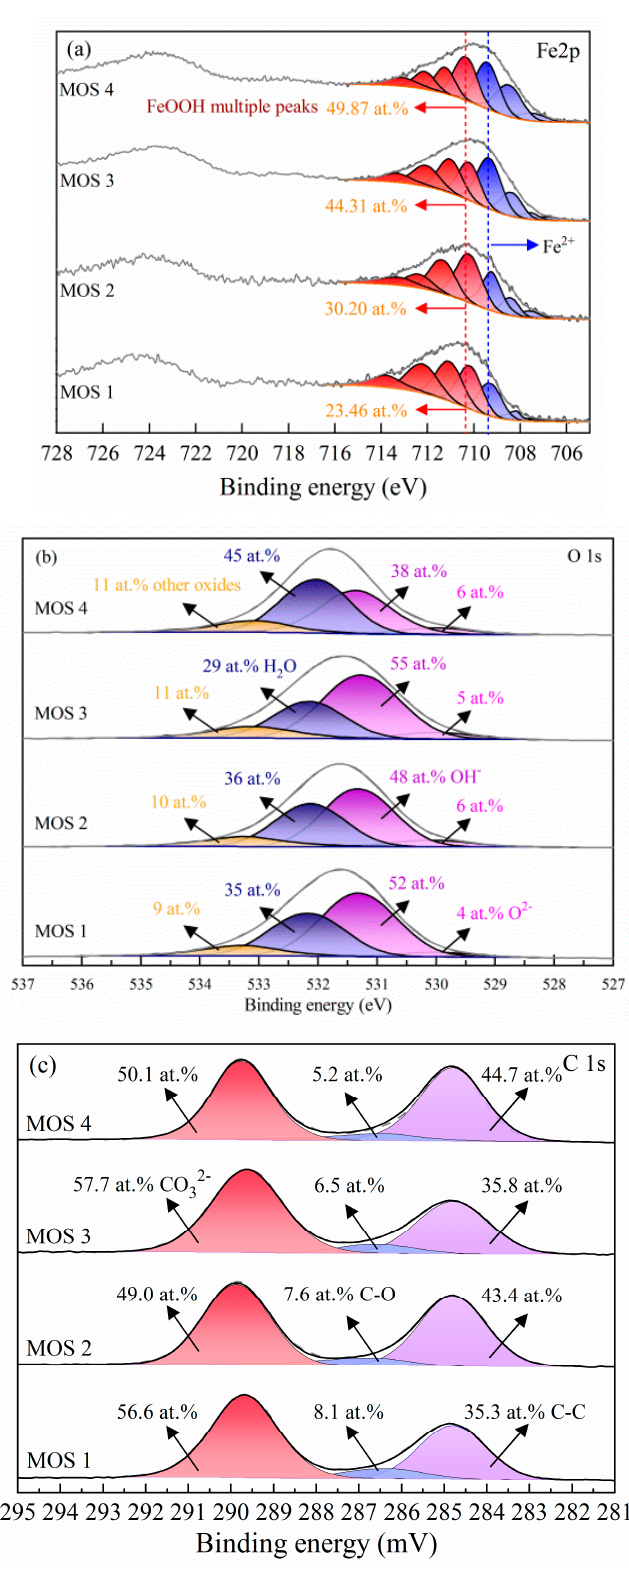
Figure 6. Fe 2p ( a ), O 1s ( b ), and C 1s ( c ) spectra recorded from the dolomite surface with 10 − 3 M Fe 2+ without (MOS 1) and with 10 − 3 M SBX (MOS 2), and 10 − 2 M Fe 2+ without (MOS 3) and with 10 − 3 M SBX (MOS 4) (pH = 8.5). RSF (Fe) = 14.353; RSF (O) = 2.881.